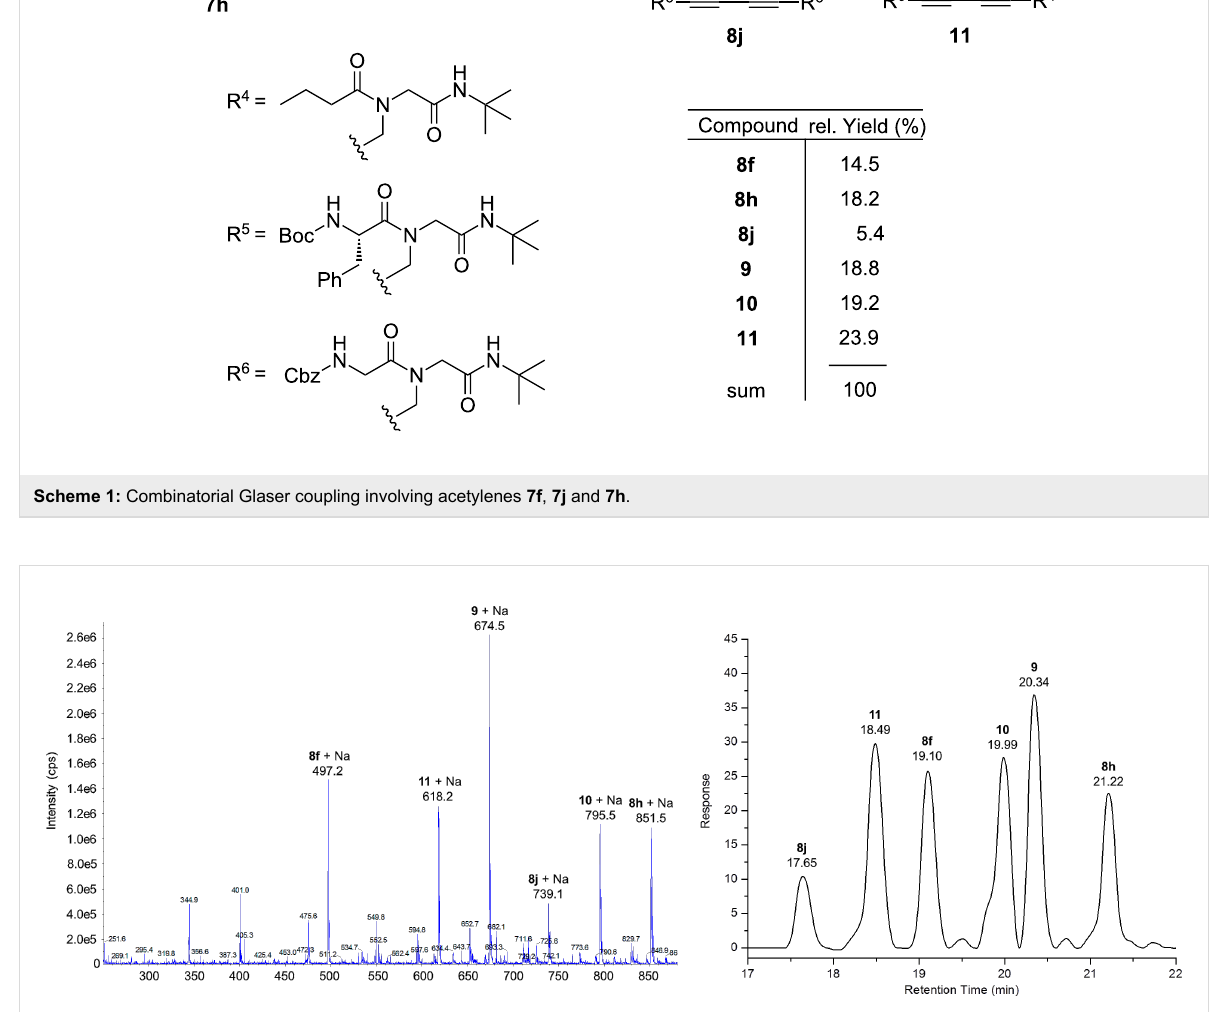
active compounds inhibited bacterial growth in a range from 29% to 44% at 1 μ M concentration, while erythromycin as the standard led to a growth inhibition of 71% under the same assay conditions. The most active compounds were 8b , 8d and 8h which displayed inhibition rates (%) of 44.0 ± 26.7, 44.0 ± 21.8 and 43.9 ± 23.0. Interestingly, compounds 8c and 8f showed almost no effect on bacterial growth, i.e., 1.3 ± 5.1% and 2.3 ± 13.5%, respectively, i.e., the diyne core fulfils its function as linker and spacer without itself negatively (or positively) influencing the specific activity of the active ligand